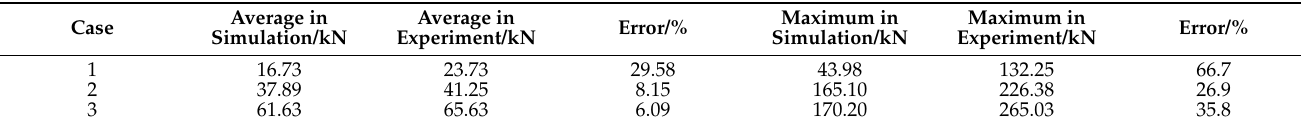
Table 4. Comparison of simulated and measured ice